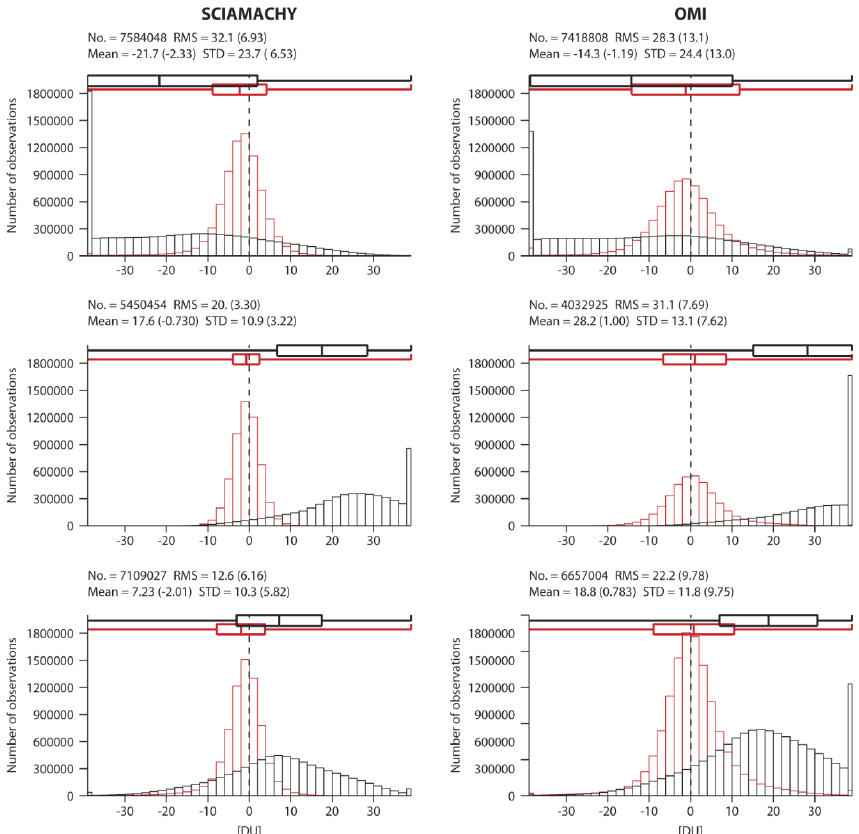
Figure 8. Histograms of SCIAMACHY (left) and OMI (right) TCO3 analysis departures in DU for CIFS-AN (red) and CIFS-CTRL (black) for 2008 averaged over the NH (90–20 ◦ N, top), the tropics (20 ◦ N–20 ◦ S, middle) and the SH (20–90 ◦ S, bottom) for all good data. Also shown above the panels are the number of observations that make up the average, as well as the mean, RMS and SD of the departures with values for REAN in